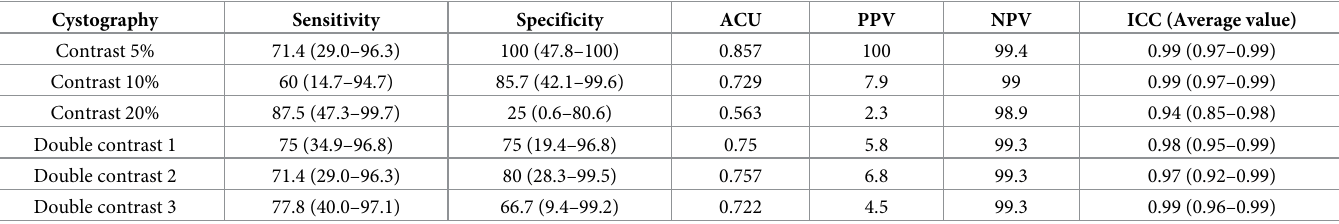
Table 1. Sensitivity and specificity tests, accuracy, positive predictive values (PPV), negative predictive values (NPV), and intraclass correlation coefficient (ICC) in the evaluation of 86 radiographic images of dogs submitted to positive and double-contrast cystography at different contrast concentrations.